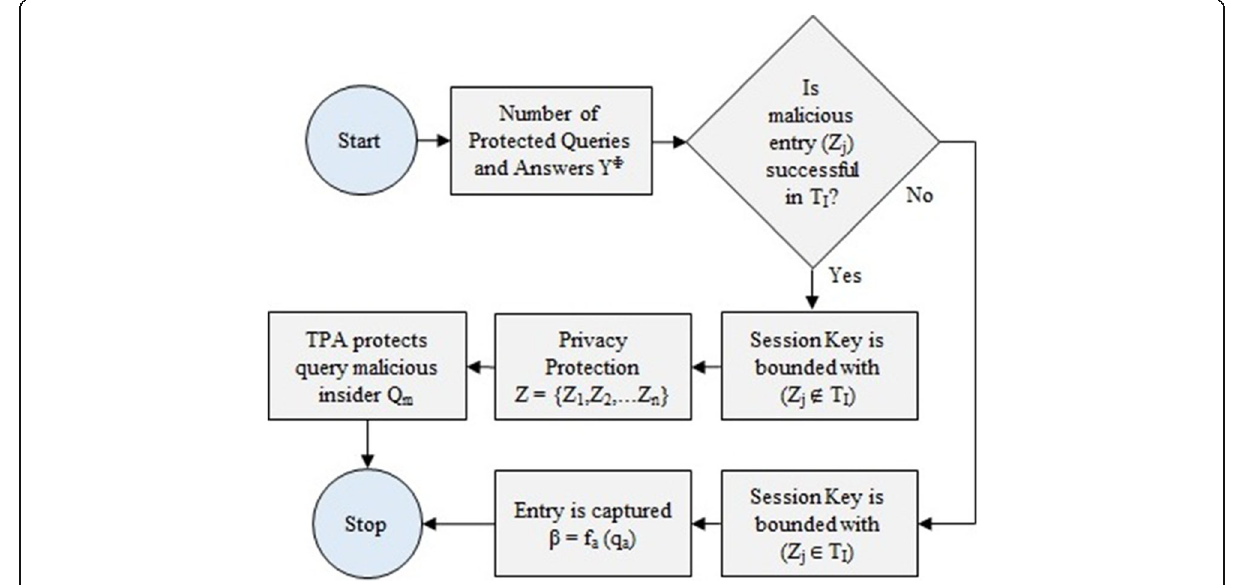
Fig. 4 Working process of malicious insider and TPA for guaranteeing the privacy-preserving authentication